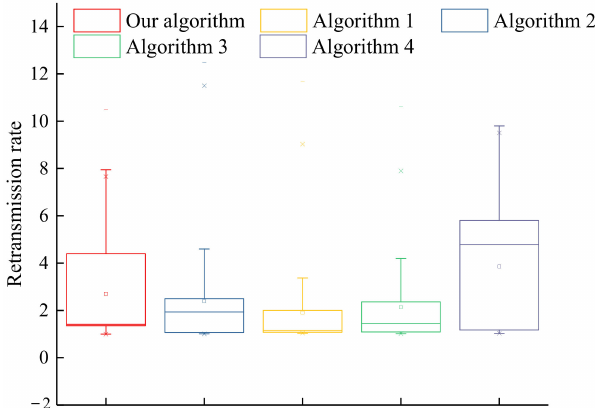
Figure 10. Box graph of RR.